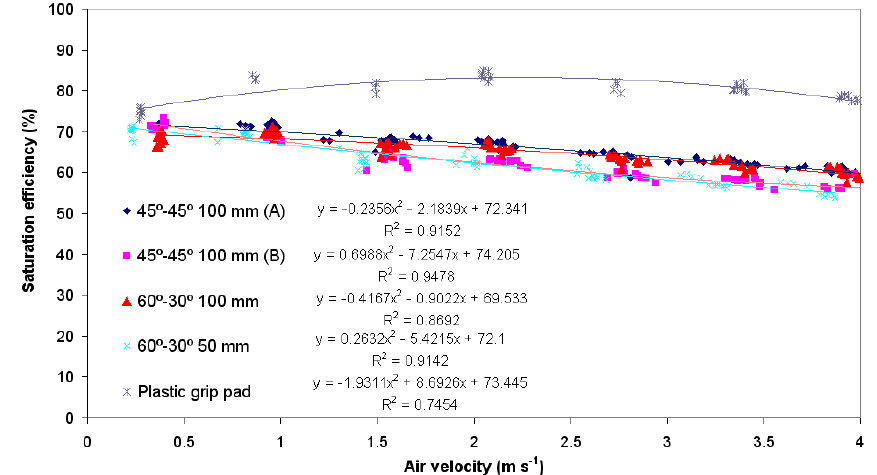
Figure 7. Comparison of the air saturation efficiency of the cellulose pads and the plastic grid pad at different air velocities and water